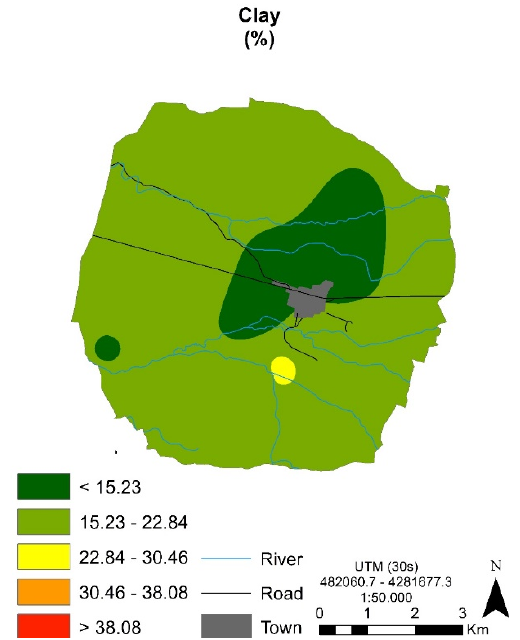
Figure 2. Spatial distribution of textural clay contents.